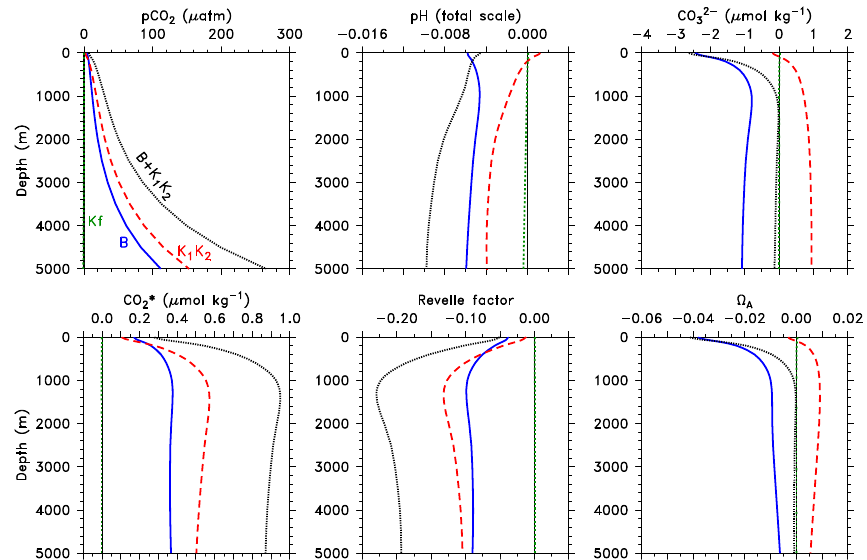
Figure 9. Absolute changes in global-mean vertical profiles of computed variables due to replacing best-practice recommendations with the three options mentioned in Fig. 8.